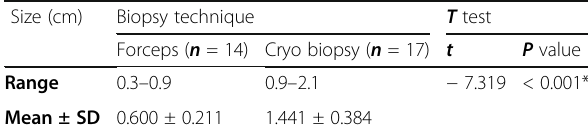
Table 2 Size of biopsies in the bronchoscopic group Size (cm) Biopsy technique